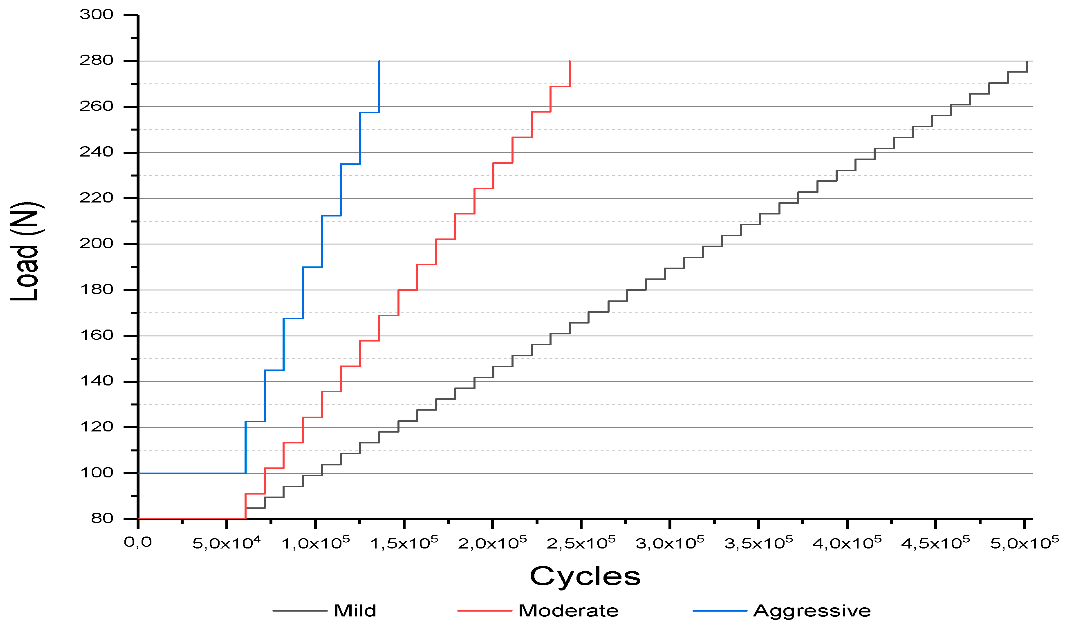
Figure 2. The step-stress profiles utilized for accelerated life testing (SSALT) on the basis of the mean value of single load to failure (SLF).